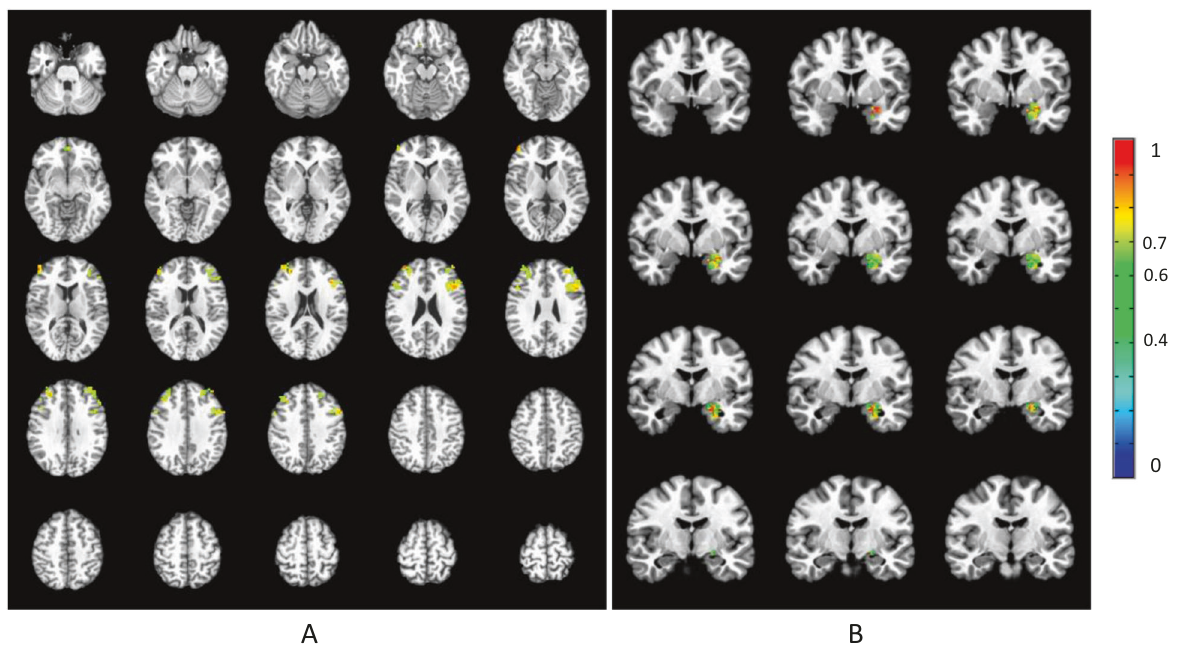
Fig. 1 Test-retest reliability in ROIs estimated with voxel wise ICCs using height parameter. A threshold of ICC > 0.4 and cluster correction areapplied for this threshold. In panel A. , the results are represented for the Siegle et al. (2012) dataset of patients and in panel B ., the results are represented for Young et al. (2017) data set of the transfer run in the experimental group (signal with training) preprocessed with the TBV style pipeline.